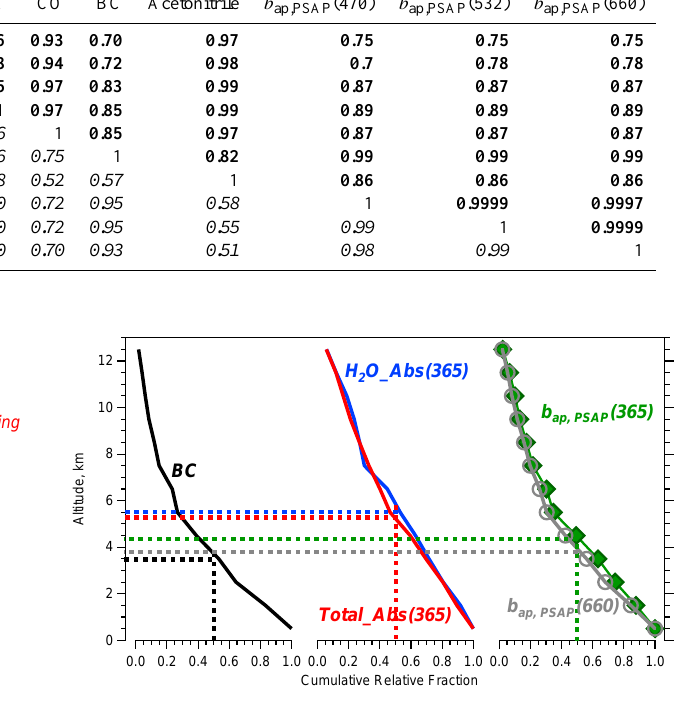
Figure 3. Vertical profile of the relative cumulative fraction (summed over all altitudes above vs. the total column), for BC (SP2), BrC at 365nm based on extract solution absorption, PSAP absorption at 660nm, and estimated PSAP total aerosol absorption at 365nm, during background tropospheric